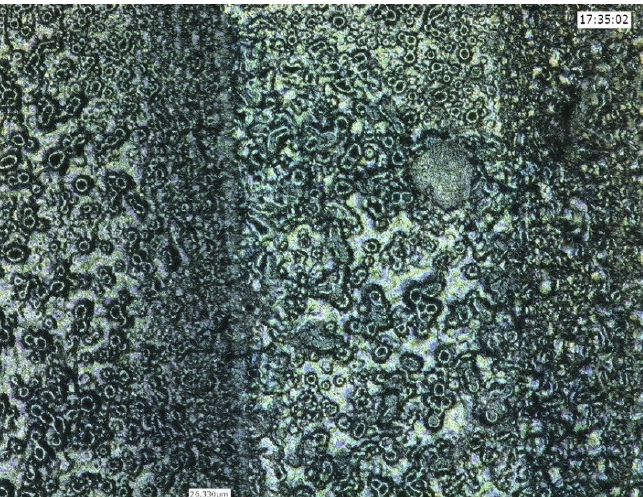
Figure 3. Anodized implant surface demonstrating areas of flattening and disappearance of the typical “crater” appearance, meaning particle detachment (lighter areas).